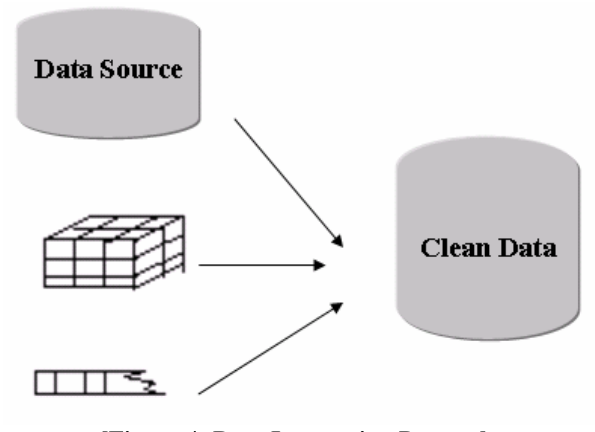
[Figure 7: Clustered data]